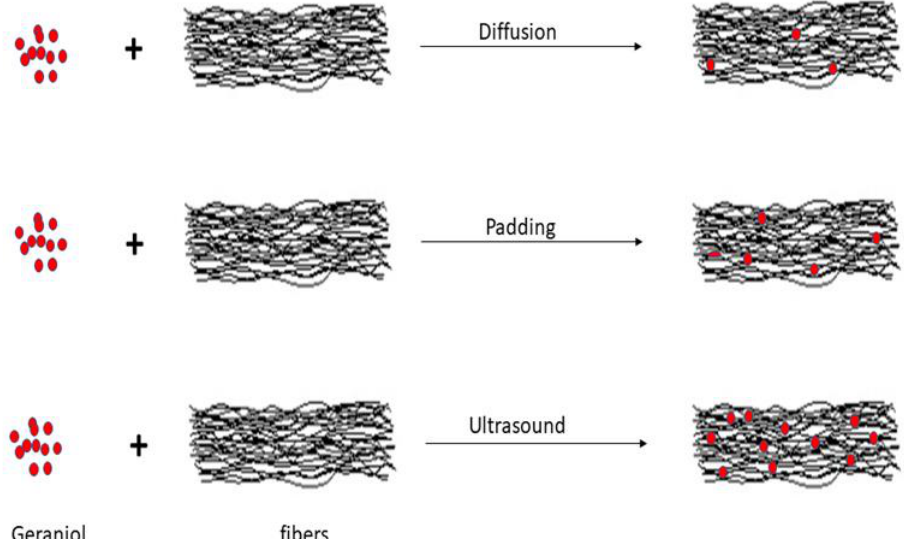
Scheme 3. Illustration of the geranium oil absorption into PET and CO fibers via different methods.